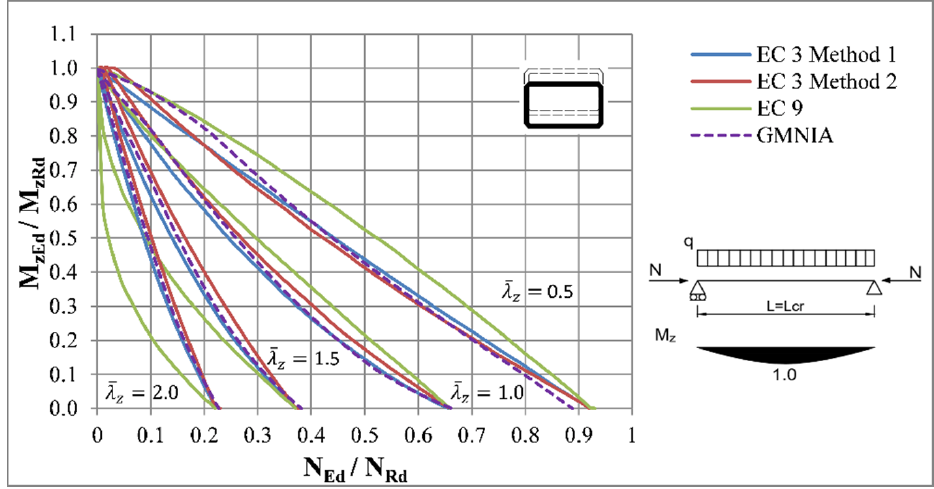
Figure 45. Interaction curves for weak axis flexural buckling of beam-columns with RHS cross-section.